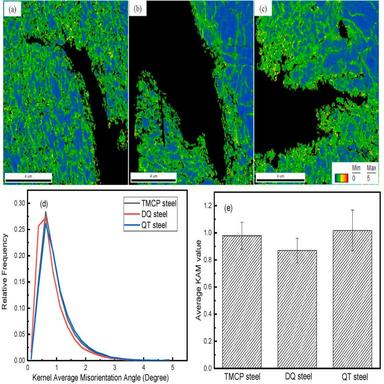
KAM distribution maps of cross-sectional cracks of different test steels at − 1200 mV (a) TMCP steel, (b) DQ steel, (c) QT steel, (d) KAM distribution curves, and (e) average KAM value.